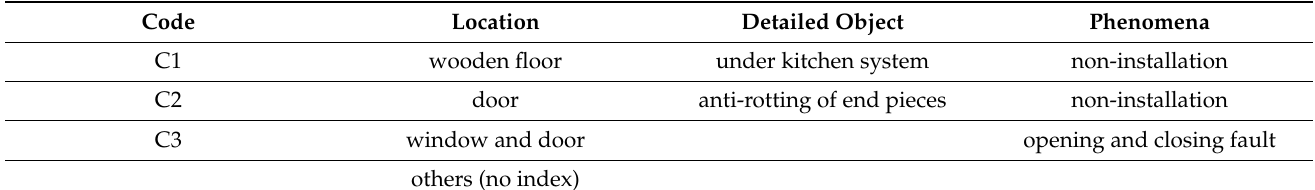
Table 4. Defect index list on judged standard of